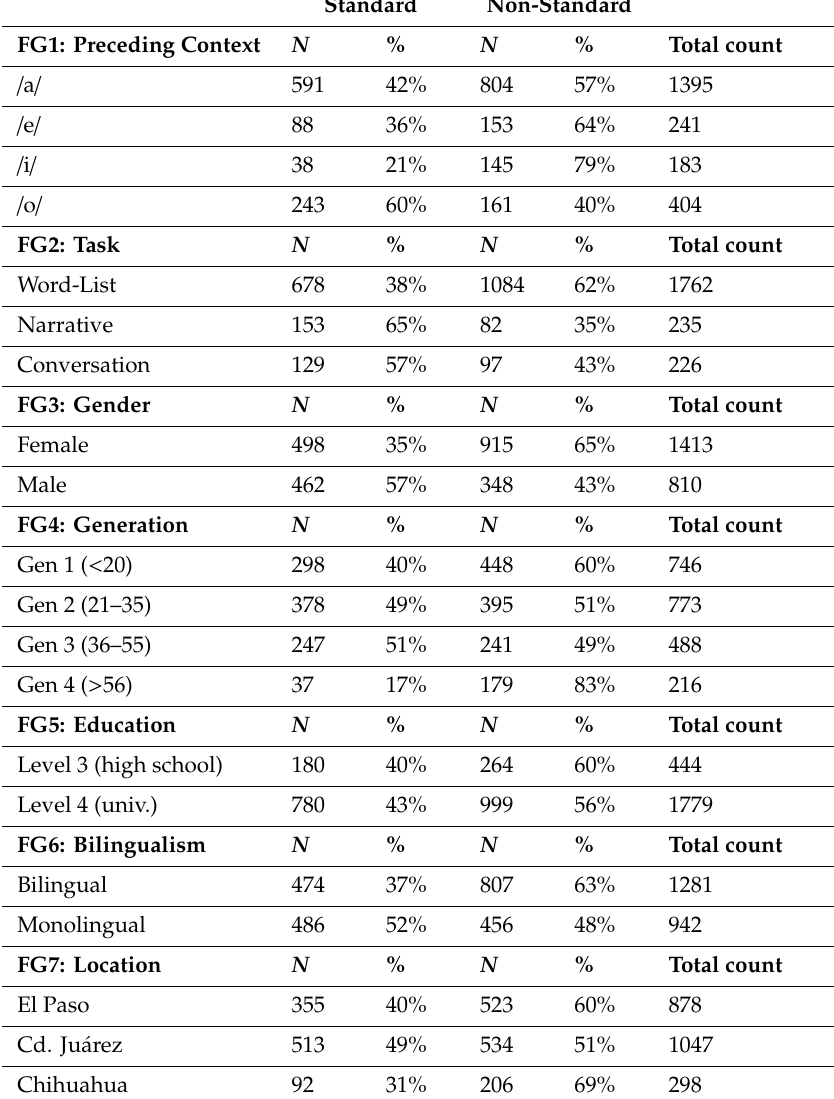
Table 3. Distribution of standard and non-standard (r) across linguistic and social factor groups.